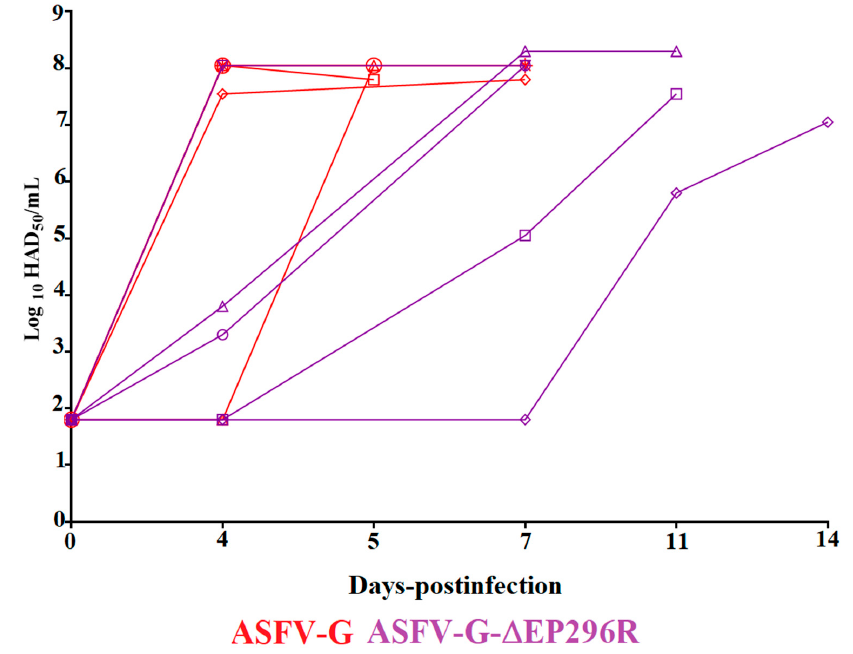
Figure 8. Viremia titers detected in pigs IM inoculated with 10 2 HAD 50 of either ASFV-G- ∆ EP296R, or ASFV-G. Each curve represents individual animal titers. Sensitivity of virus detection: >log 10 1.8 TCID 50 / mL . Significant differences in viremia titers between the two groups were detected at day 4 post infection, calculated using the unpaired t -test considering the two-stage step-up (Benjamini, Krieger, and Yekutieli) method. The significance was evaluated using the false discovery rate method (FDR), with q -values <0.05 considered significant. All calculations were conducted using the software GraphPad Prism version 9.2.0.